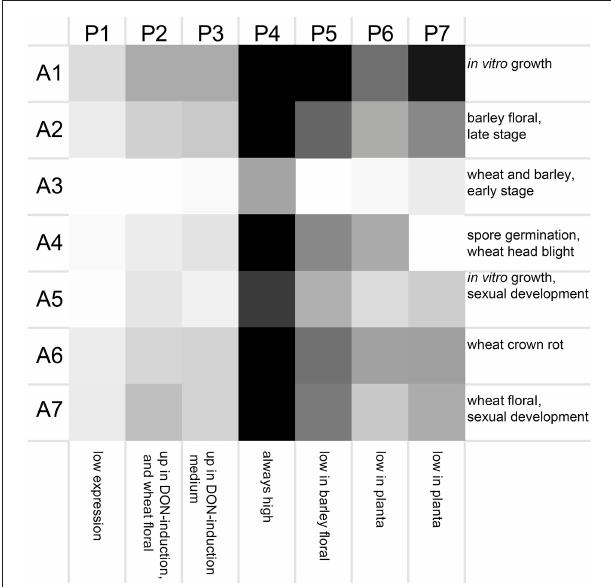
FIGURE 2 | Averaged gene expression profiles for seven clusters of peptidases. Average values for peptidase (P1–P7) and microarray (A1–A7) clusters are plotted as a heat map (black, high expression; white, low expression). Characteristic treatments used in each array cluster are listed for each row, and characteristics of each peptidase expression profile are listed for each column.